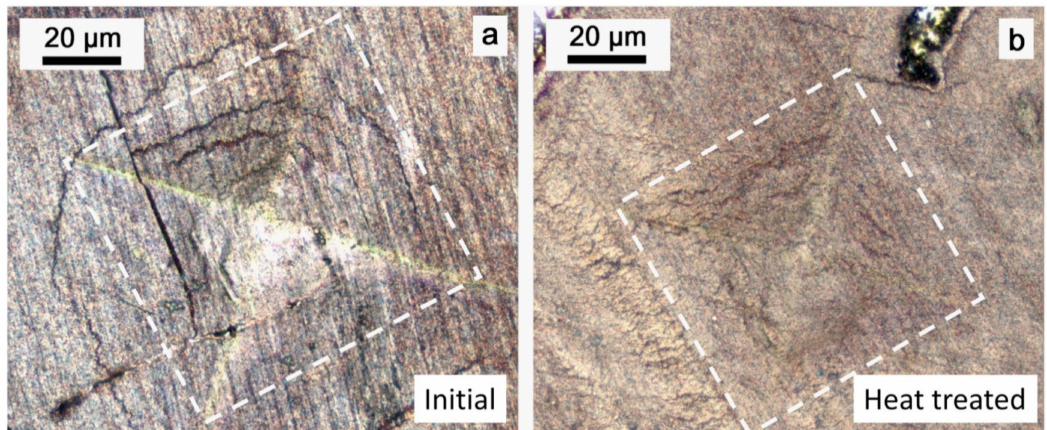
Figure 6. Surface patterns under the indenter after hardness measurement of the initial ( a ) and the heat treated ( b ) foams. The dashed white square indicates the surface area under the loaded indenter.